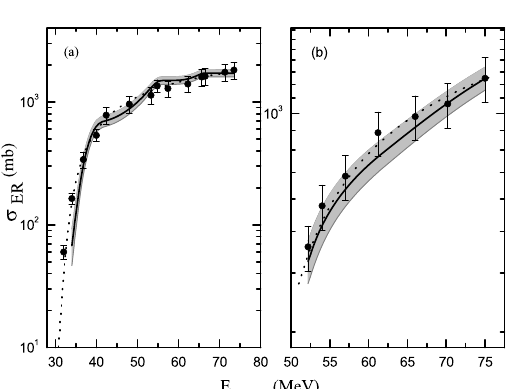
Figure 1: The comparison of the experimental cross-sections (solid circles) with the theoretical calculations for (a) 16 O + 64 Zn, (b) for 32 S + 48 Ti. The solid line corresponds to the TDHF calculations and shaded area represents the uncertainty in cross-sections obtained from the TDHF calculations. The dotted lines corresponds to the CCDEF